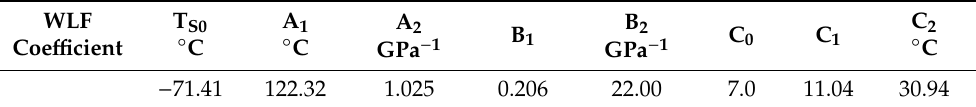
Table 1. Coe ffi cients of the WLF formula describing the pressure and temperature dependence of lubricant viscosity [16].